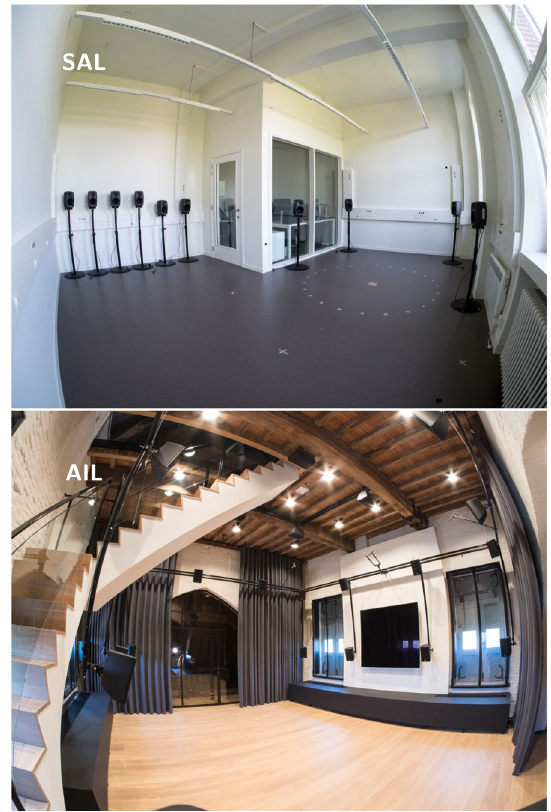
Fig. 1 Fisheye view of the SAL and the